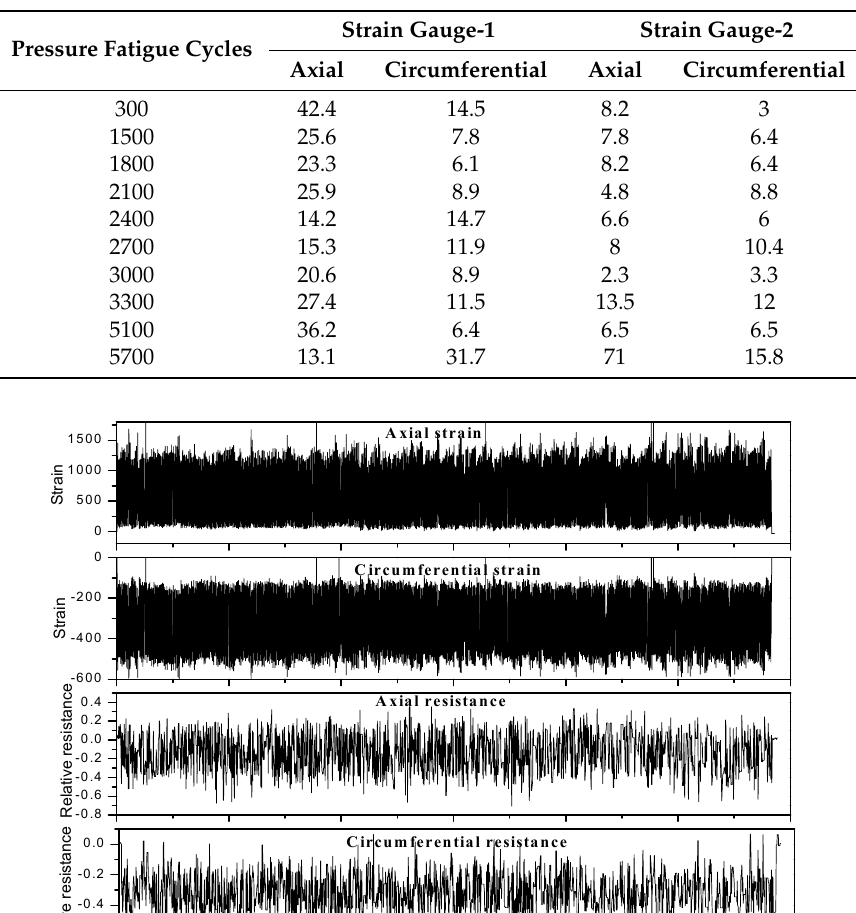
Table 4. The residual strain as a function of pressure fatigue cycles.